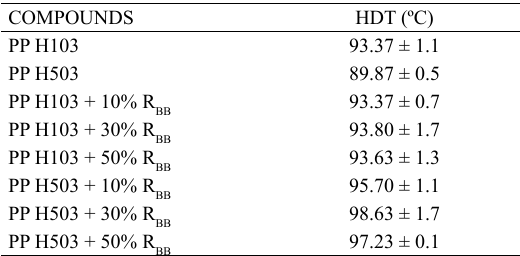
Table 5. HDT of PP H103, PP H503 and PP/R BB